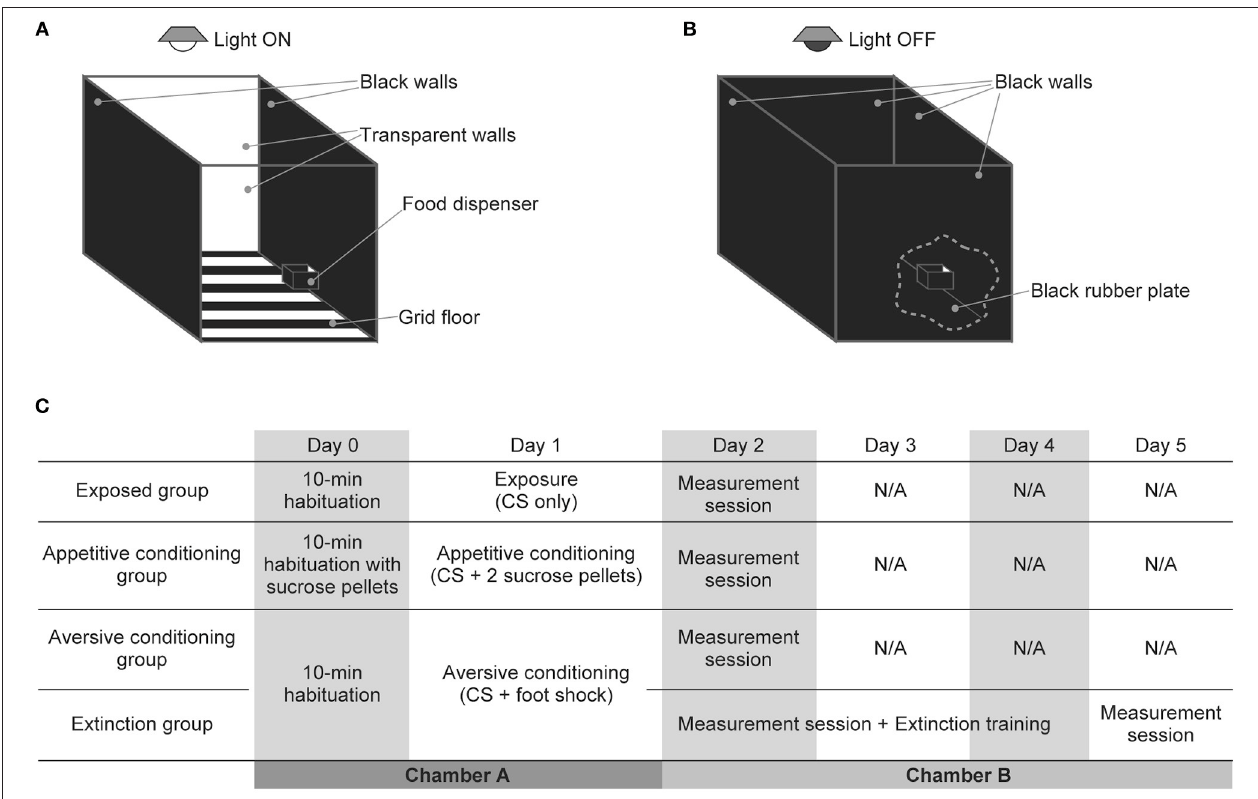
FIGURE 1 | Experimental setup and design of auditory exposure, classical conditioning, and extinction. (A,B) Schema of the experimental setup for (A) auditory exposure and classical conditioning and (B) auditory extinction and the measurement session. There was a food dispenser in one of the black walls to supply sucrose tablets for rats in the appetitive conditioning group. Three elements changed in the measurement session and auditory extinction. (i) The light above the experimental chamber was turned off, (ii) the grid floor that delivered the foot shock was covered with a black rubber plate, and (iii) two transparent walls of the chamber were replaced with black walls. These changes prevented contextual conditioning and also emphasized the contrast between the white rats and black walls and floor, which enabled easier behavioral measurement from camera-captured images. (C) Schedule for the exposure, classical conditioning, and